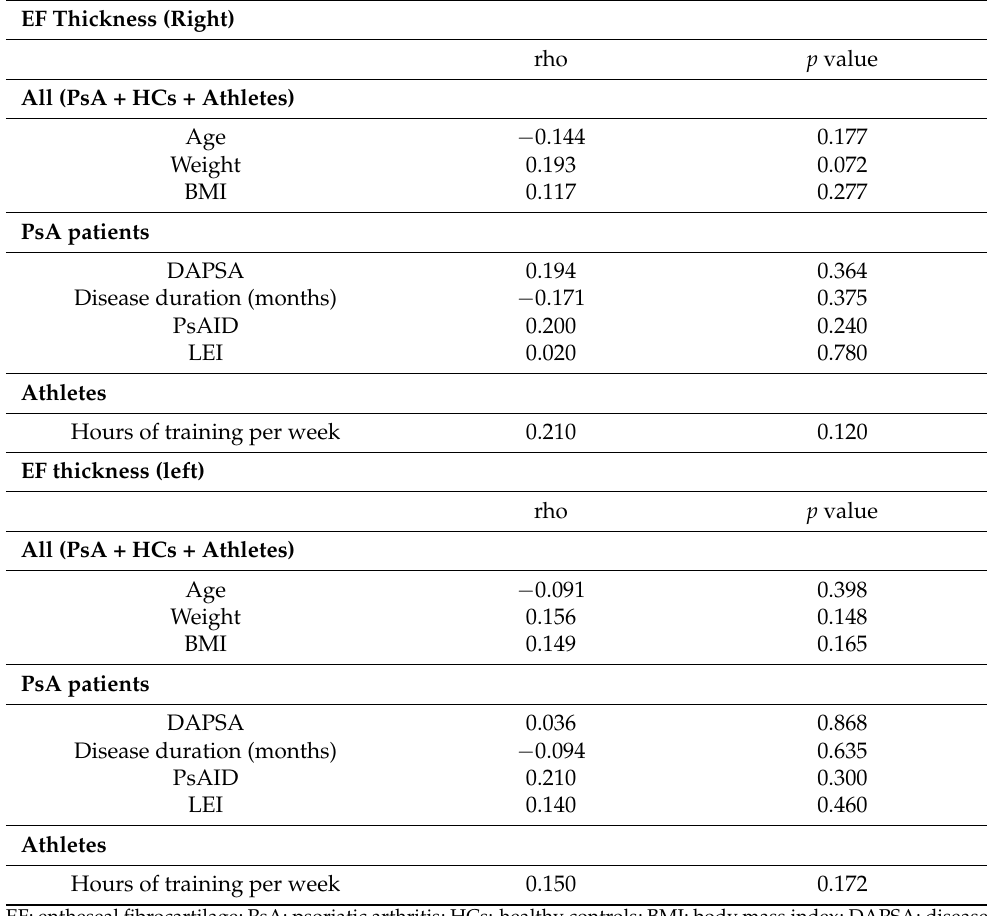
Table 3. Correlation between EF thickness and clinical characteristics in our group of patients.